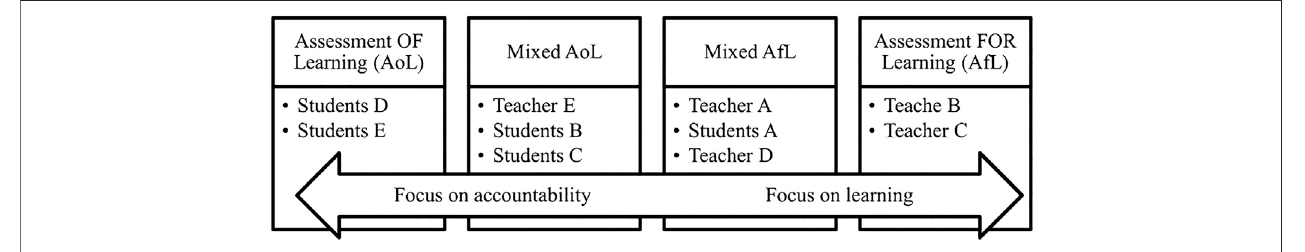
FIGURE 1 | Description of the Conceptions of Teachers and